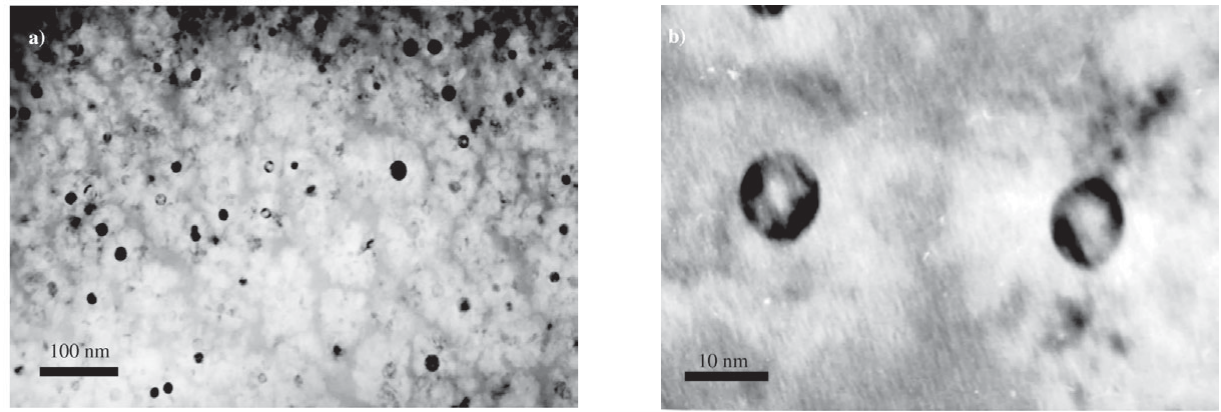
Figure 4 . Dispersed oxide particles in the ODS coatings observed by TEM, showing nano-sized, spherical balls of Y Fe-Cr-Ni-Al-Y O 2 3